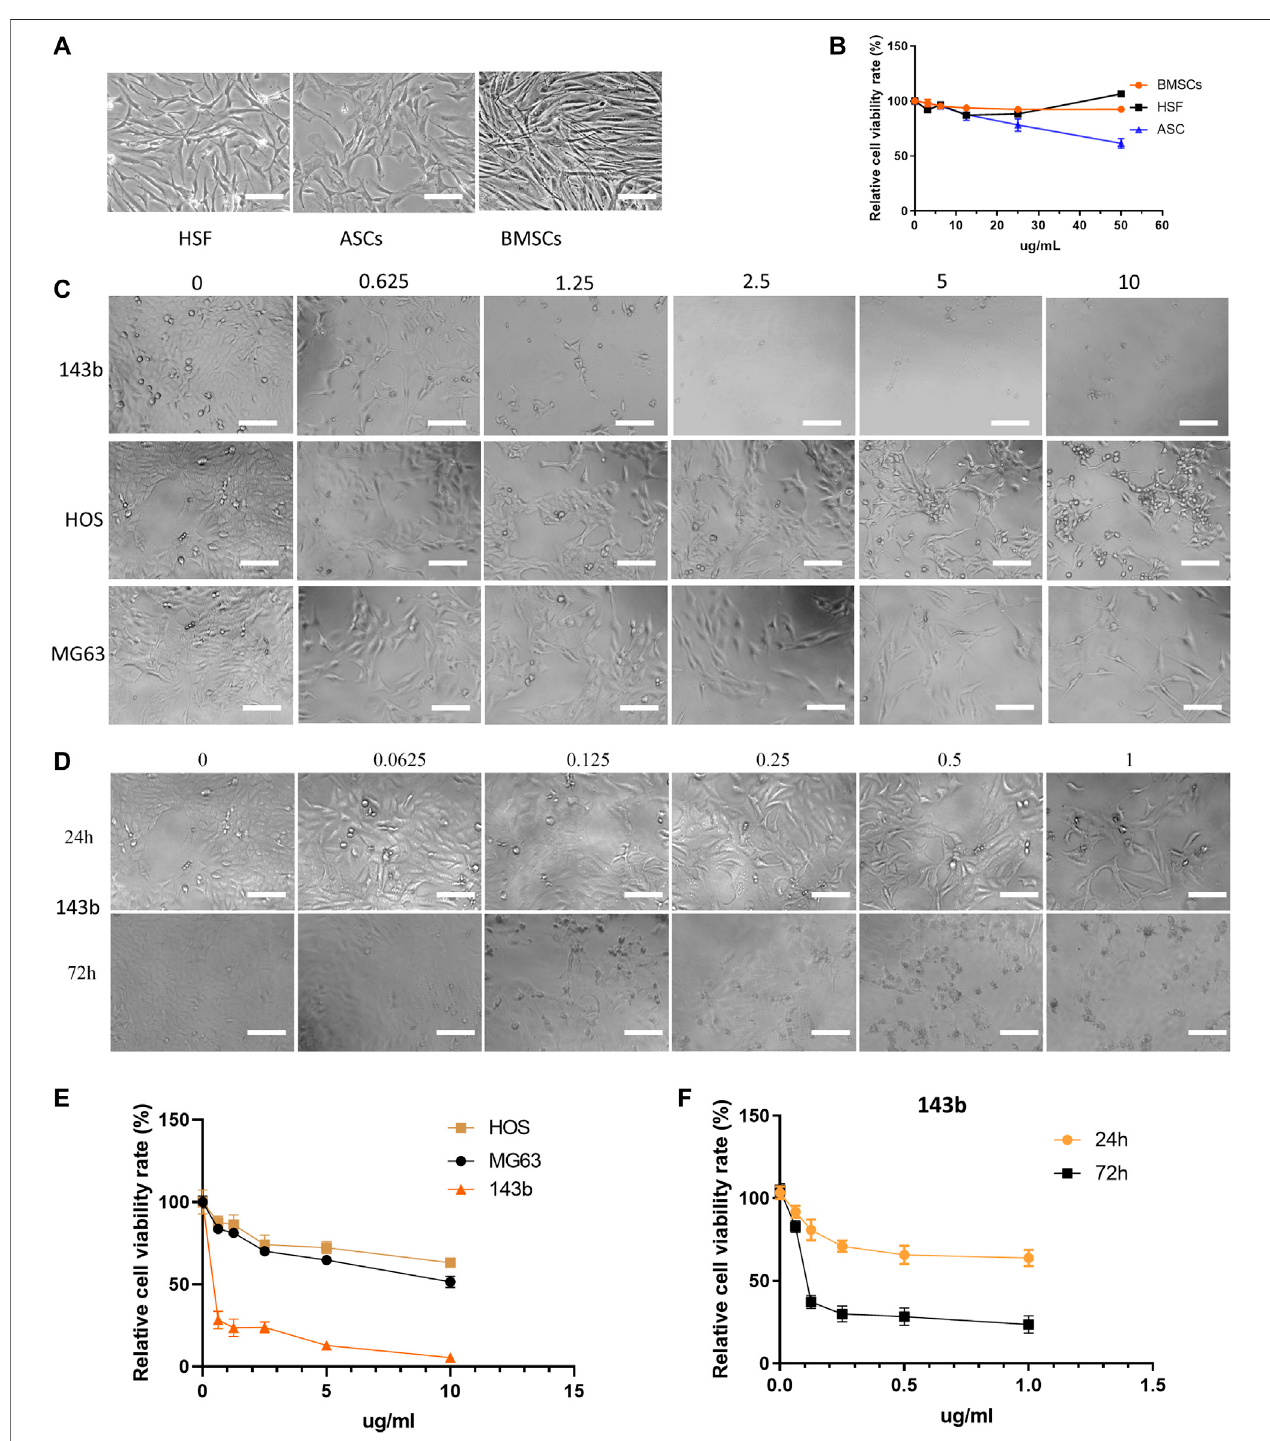
FIGURE2| Effectofnanoparticlesonthreetypesofnormalcellsandthreeosteosarcomacelllines. (A) Photoscopicimagesofthreenormalcelltypes(HSFs,ASCs, and BMSCs) treated with 0 – 50 μ g/ml concentrations of nanoparticles. (B) Relative cell viability of three normal cell lines under 0 – 50 μ g/ml concentrations of nanoparticles. (C,E) Photoscopic images and relative cell viability of three kinds of osteosarcoma cells (143b, HOS, and MG63) treated with 0 – 10 μ g/ml concentrations of nanoparticles. (D,F) Photoscopic images and relative cell viability of 143b cells treated with 0 – 1 μ g/ml concentrations of nanoparticles. Scale bar = 100 um.